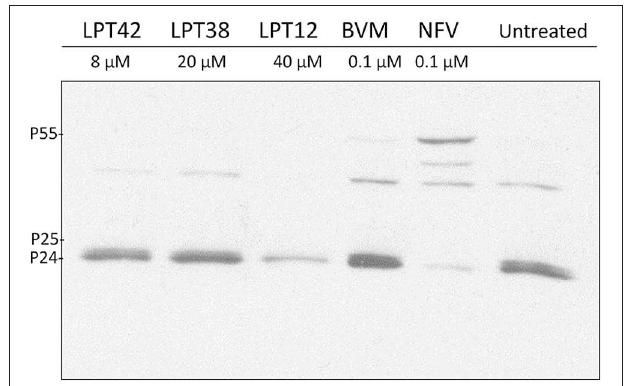
FIGURE 10 | Detection of p24 processing in wild type NL4.3 HIV-1 strain after treatment with LPTs. 293T cells were transfected with HIV-1 (NL4.3) and incubated in presence of LPT12 40 µ M, LPT38 20 µ M, LPT42 8 µ M, bevirimat (BVM) 0.1 µ M, nelfinavir (NFV) 0.1 µ M or left untreated for 24h at 37 ◦ C. Two days after transfection supernatants were collected and submitted to several rounds of concentration by ultra-centrifugation. Total proteins were then extracted and immunodetection of specific proteins was carried out with a monoclonal antibody against HIV-1 Gag p24